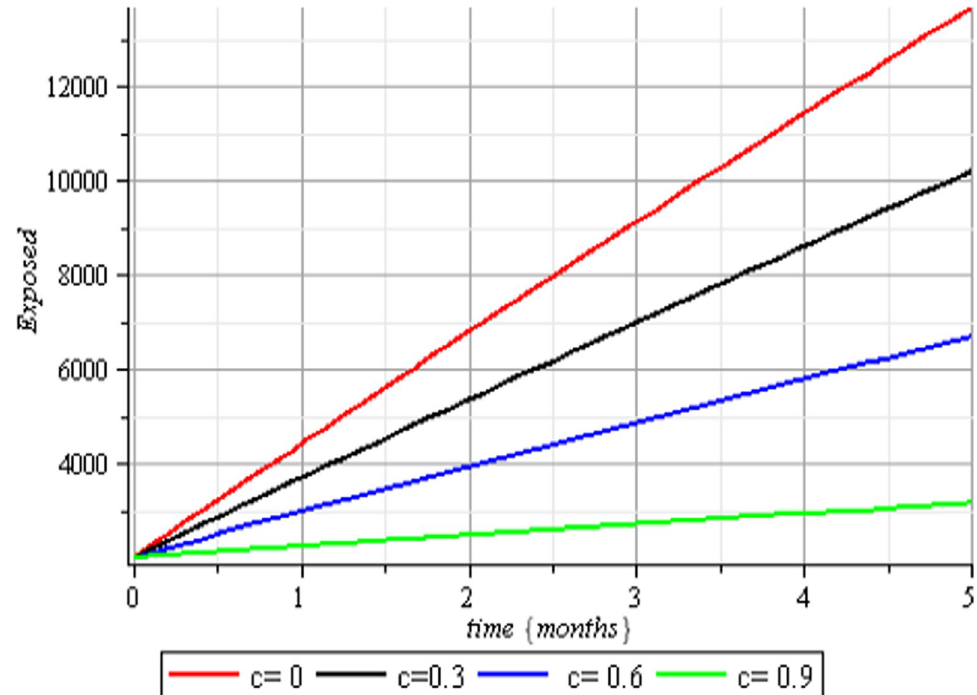
Fig. 3 Effect of human submission to physical limitation on the exposed